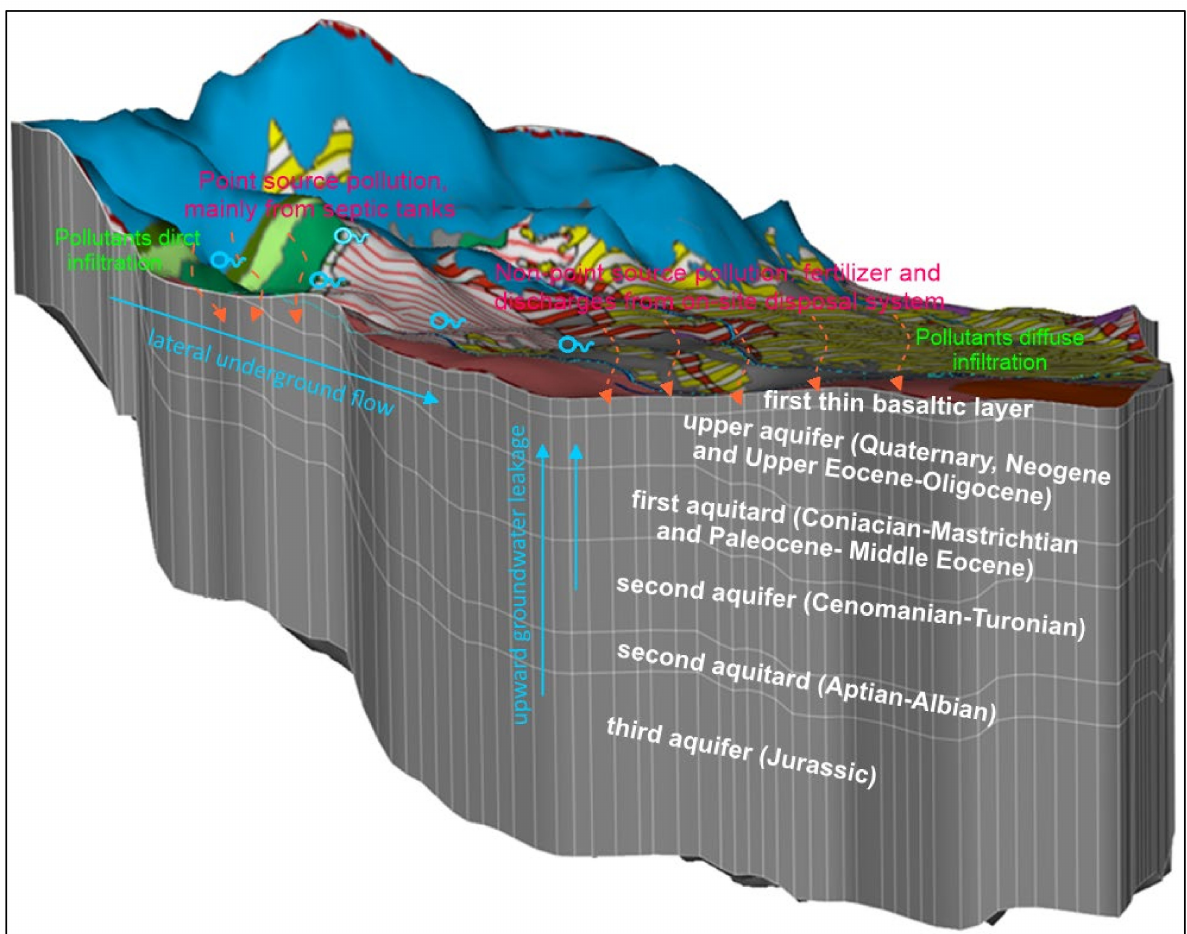
Figure 7. A 3D representation of the aquifers and aquitards of NEMH area as well as pollution pathway concept, modified from